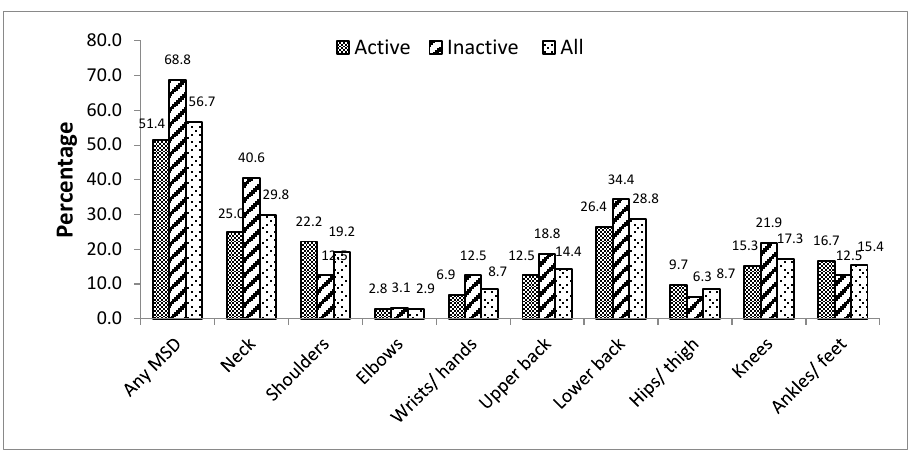
Figure 1. Distribution of MSDs during previous 7 days according to physical activity.